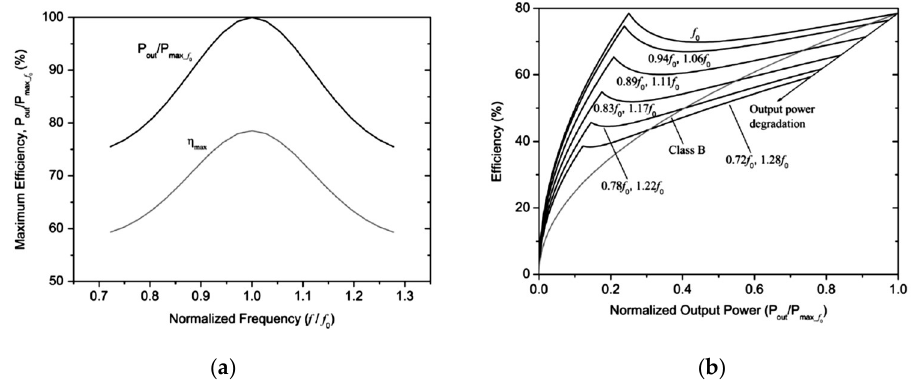
Figure 12. ( a ) Maximum efficiency and output power of DPA versus normalized frequency. ( b ) Efficiency of the DPA versus normalized output power at various frequency deviations from the center frequency [83].